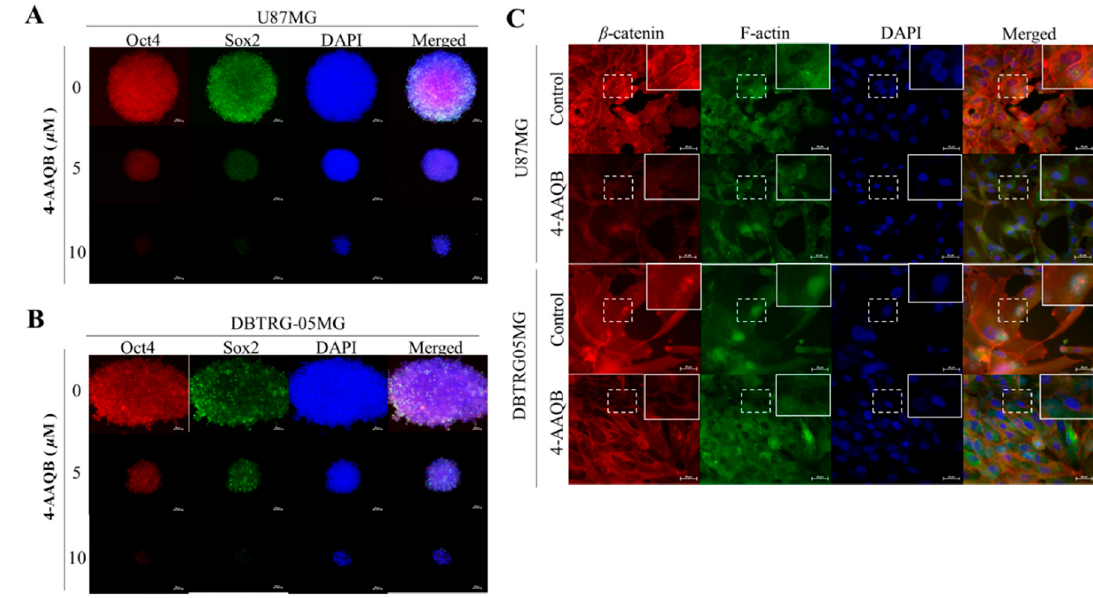
Figure 4. 4-AAQB inhibits the nuclear localization of β -catenin, Sox2, and Oct4 in GBM cells. U87MG and DBTRG-05MG cells treated with or without 5–10 µ M 4-AAQB were immunostained with Sox2 (green), Oct4 (red), β -catenin (red), and F-actin (green) antibodies, then image visualization and analysis carried out by fluorescence microscopy. Treatment with 5 or 10 µ M 4-AAQB markedly decreased nuclear Sox2 and Oct4 protein expression in ( A ) U87MG or ( B ) DBTRG-05MG cells. ( C ) Immunohistochemistry show reduced nuclear expression of β -catenin and F-actin after treatment with 10 µ M 4-AAQB. Original magnification × 200. DAPI (blue) served as nuclear marker.